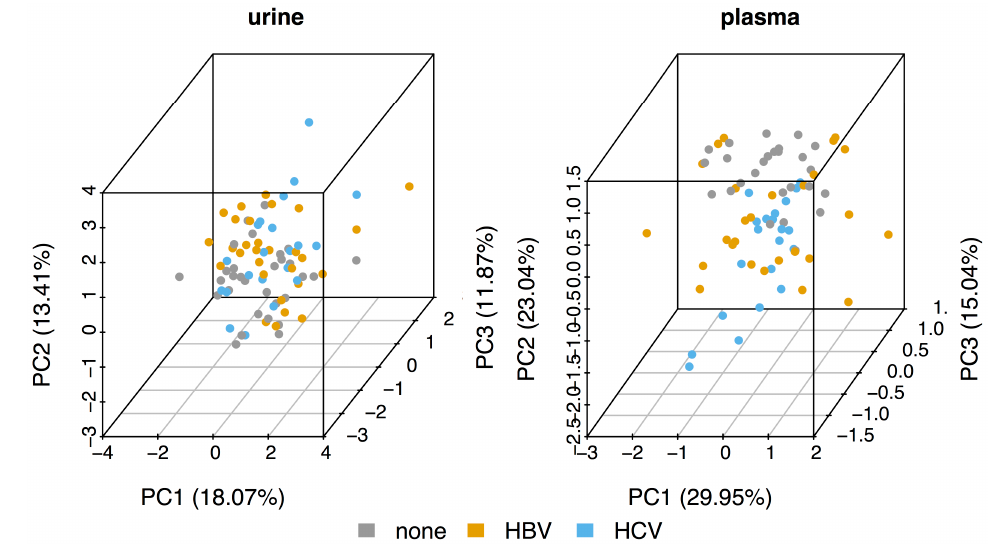
Figure 1. Principal component analysis (PCA) for the urine and plasma datasets.